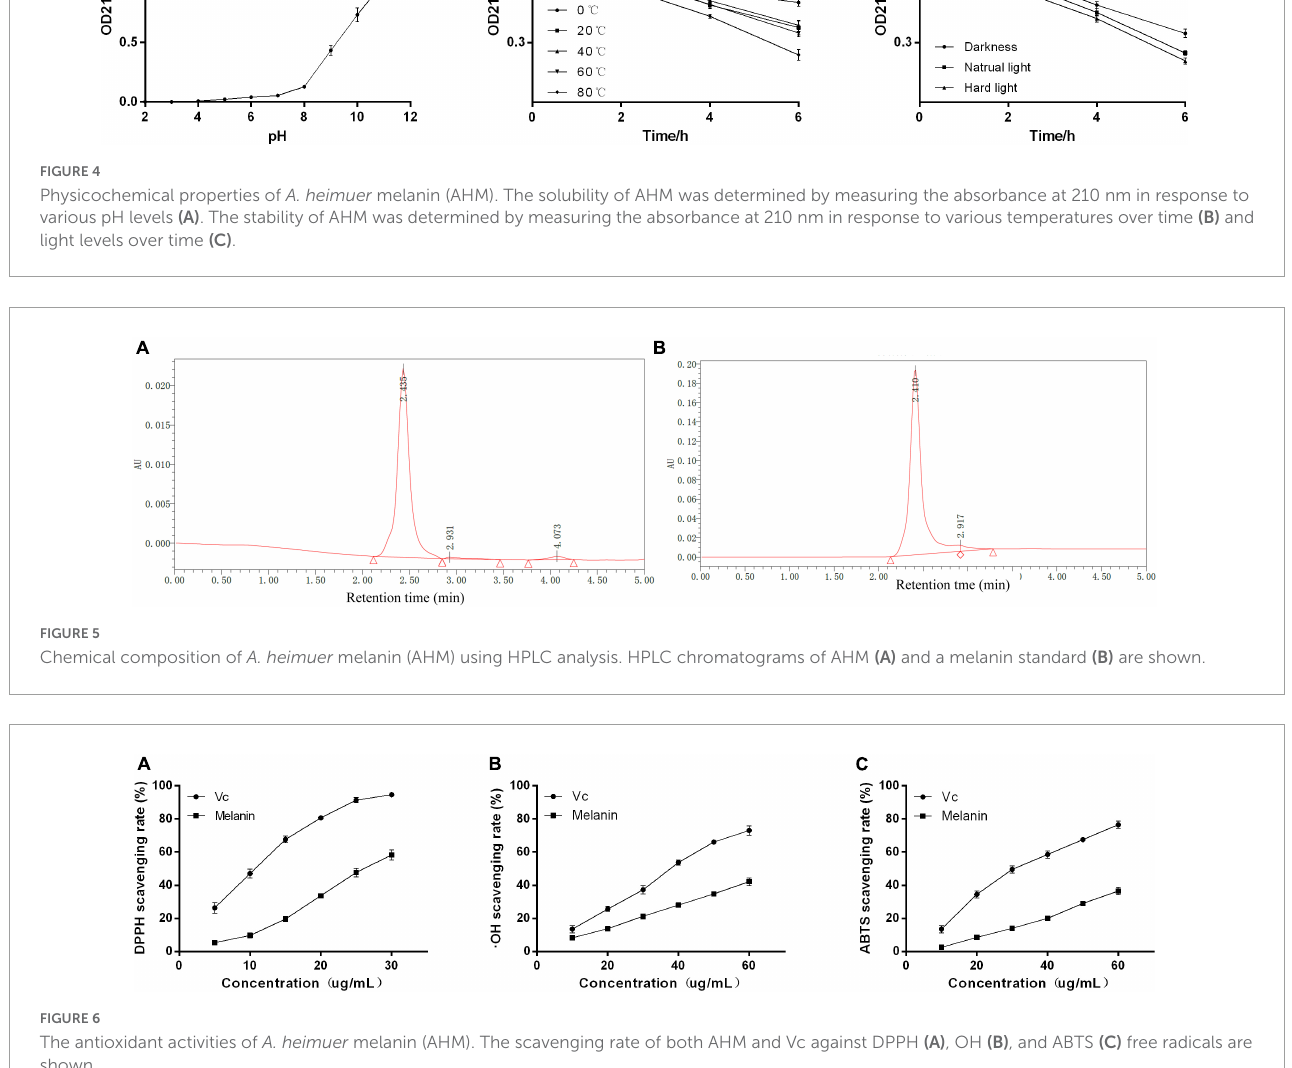
yield predicted by the model. As a result, RSM was found to be